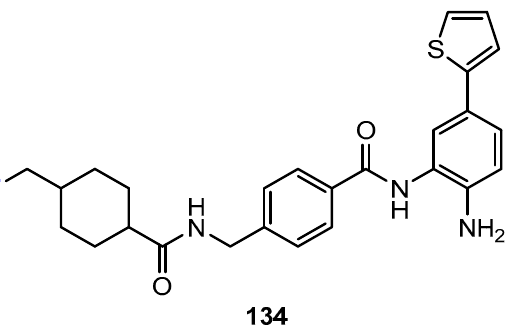
Figure 7. Chemical structure of fluorinated benzamide (CBUD-1001) by Kim, La et al.